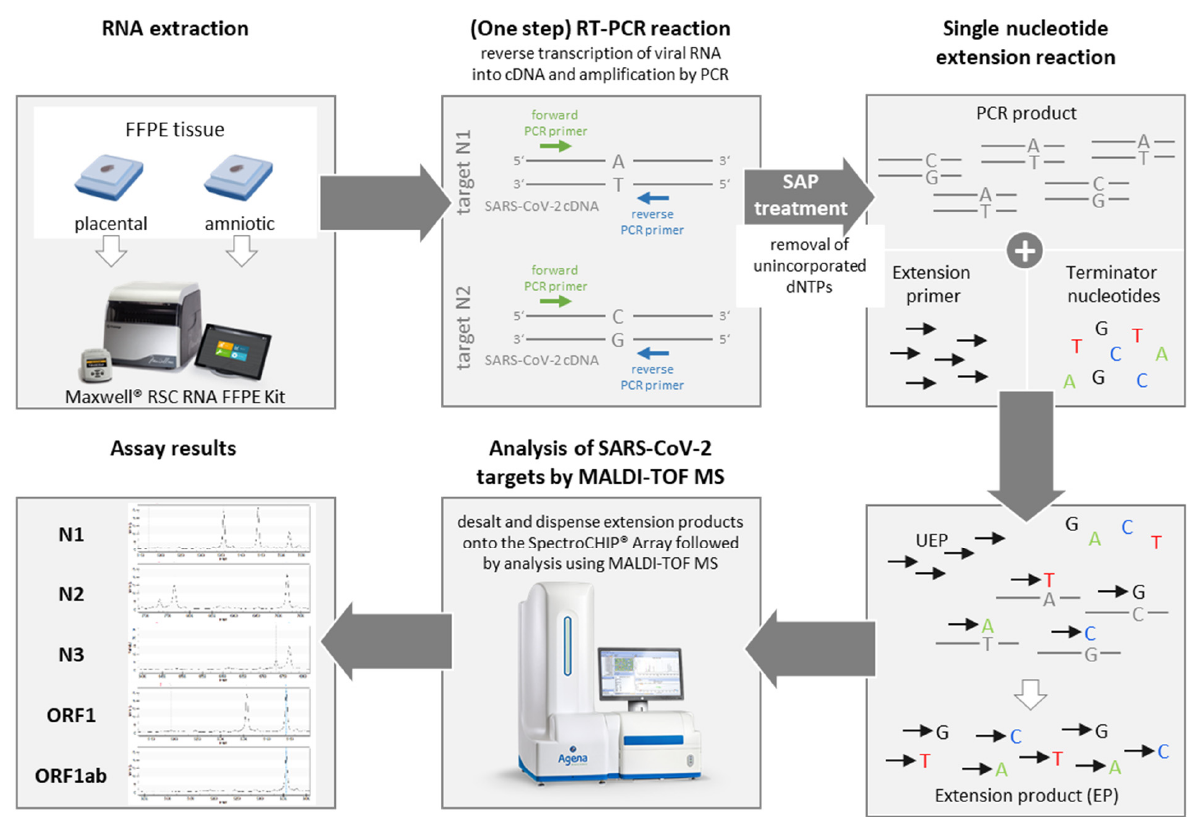
Figure 1. Workflow and molecular principle of SARS-CoV-2 RNA detection in FFPE tissue by MALDI-TOF mass spectrometry. RNA extraction from FFPE placental and amniotic tissue was performed using the Maxwell RSC RNA FFPE Kit (Promega) according to manufacturer’s instructions. Extracted viral RNA is then reverse transcribed into cDNA and amplified by a one-step RT-PCR reaction. The figure schematically depicts specific amplification of the SARS-CoV-2 targets N1 and N2. The forward primers are indicated in green, the reverse primers in blue. Thereafter,